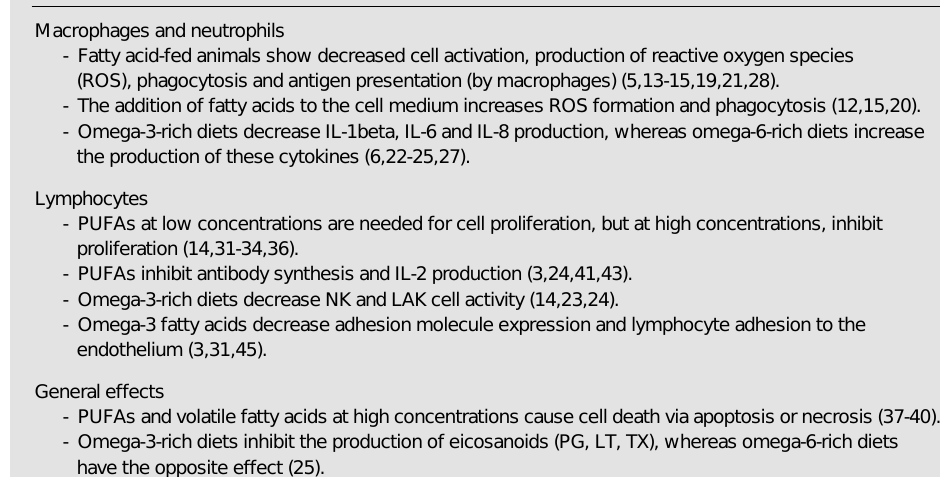
Table 1 - Summary of the effects of fatty acids on